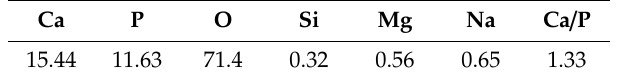
Table 4. Chemical composition of the precipitated bioactivity layer, At%.